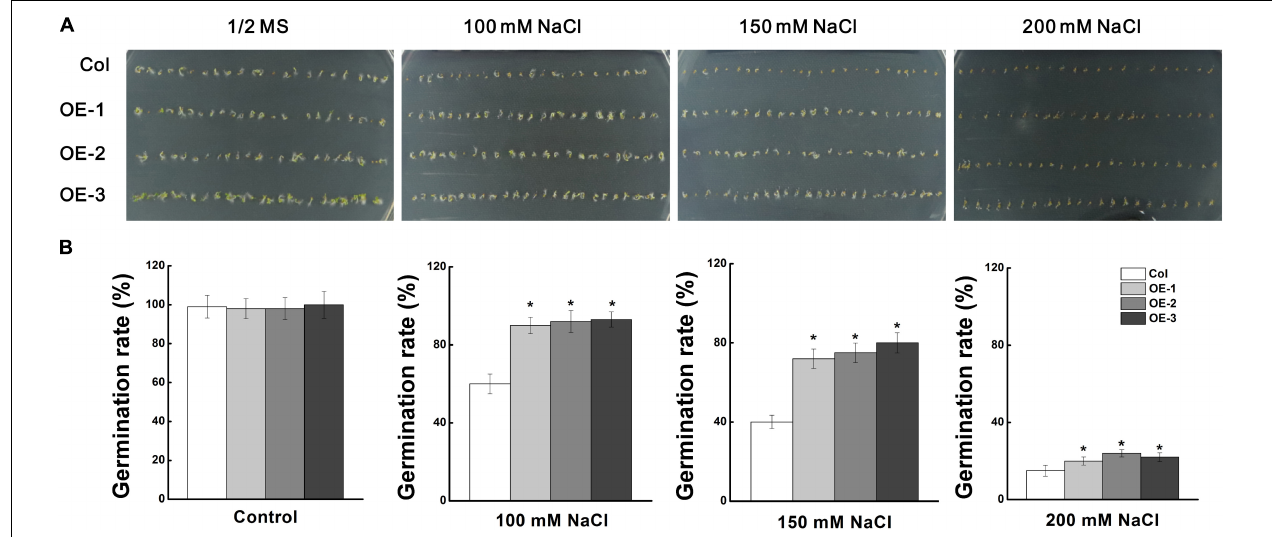
FIGURE 4 | Analysis of seed germination rate of “Col” and MdCCX1 -overexpressing transgenic lines under NaCl stress. (A) Typical picture of germination rate. T 3 seeds from MdCCX1 -overexpressing lines were dispersed on 1/2 MS medium containing different concentrations of NaCl (0, 100, 150, and 200 mM) or not for 2 d. (B) Statistics of germinated seeds in (A) . Data are average values of three independent experiments and are presented as mean ± SD. Significant differences (*) relative to the “Col” were determined using Student’s t-test : p <